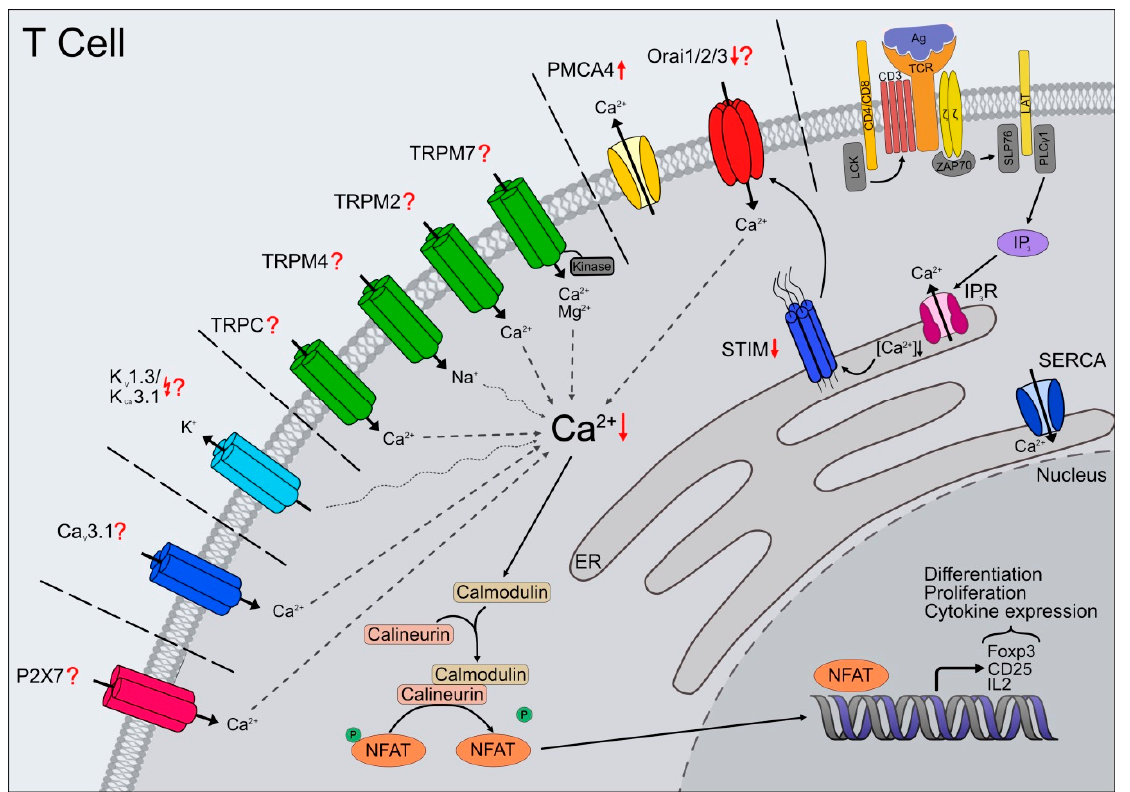
Figure 1. Altered Ca 2+ signaling in T cells during aging—impact of ion channel expression and function. Calcium signaling in T cells, mediated by several types of channels, pumps, and receptors, is part of a crucial activation pathway, leading to proliferation, differentiation, and various effector functions. Antigen recognition through T cell receptors (TCRs) initiates the phosphorylation of multiple adaptor proteins. Activation of PLC γ 1, followed by inositol triphosphate (IP 3 ) production, induces Ca 2+ release from ER calcium stores by binding to its receptor (IP 3 R). The decrease of [Ca 2+ ] ER activates STIM, which translocates to the plasma membrane and causes store-operated calcium entry (SOCE) through direct interactions with Orai channels. The increased cytosolic Ca 2+ concentration leads to the activation of calcineurin, dephosphorylation and nuclear translocation of NFAT resulting in expression of IL2, CD25, Foxp3, and further components essential for T cell function. Other ion channels including (non-selective) TRPC and TRPM2/7, Ca V channels (e.g., Ca V 3.1), and purinergic ionotropic receptors (e.g., P2X7) mediate Ca 2+ influx during T cell activation. Additionally, ion channels like potassium channels (e.g., K V 1.3, K Ca 3.1) or TRPM4 indirectly regulate Ca 2+ influx through de- or hyperpolarization of the plasma membrane. Besides alterations in TCR activation, also Ca 2+ signaling changes during aging. STIM1 and STIM2 expression levels are reduced ( ↓ ). Orai channel expression is still under investigation but Orai2 mRNA expression is decreased ( ↓ ). In contrast, PMCA4 expression increases with age ( ↑ ) leading to higher Ca 2+ extrusion. Inhibition of K V 1.3 or K Ca 3.1 causes age- and subtype- dependent differences in Ca 2+ influx patterns (`). Possible changes in expression or function of other ion channels during aging are largely unknown